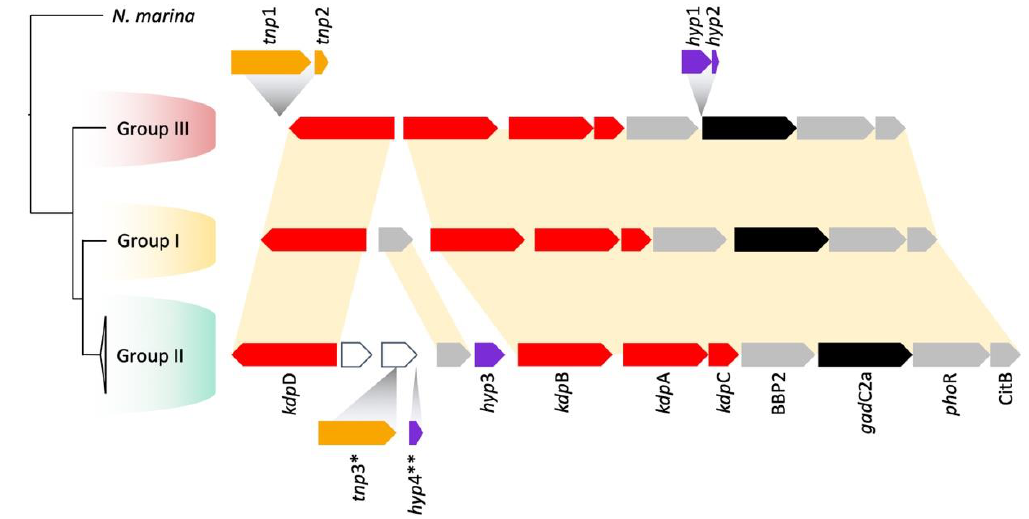
Figure 3. Phylogenetic distribution and genomic contexts of genes predicted for Kdp potassium uptake. N. marina , which lacks these genes, is included as an outgroup. Color coding of genes: red = Kdp genes, purple = orphan hypothetical genes, grey = additional genes whose genomic context is conserved, orange = predicted mobile elements and their remnants (* tnp 3 inserted only in CF-1, ** hyp 4 inserted only in the YSK strain), and black = gad C2A potentially involved proton export (see Section 3.5.2).